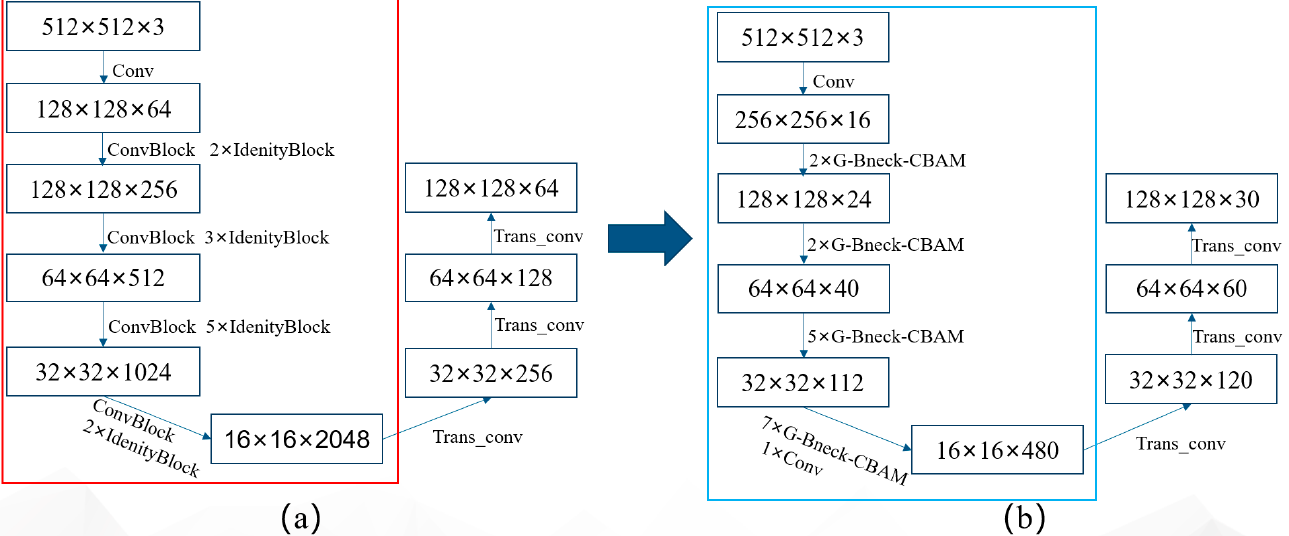
Figure 2. Two detection network frameworks. ( a ) CenterNet with ResNet50 and ( b ) CenterNet with CBAM-Mini-bone (hereinafter referred to as CBAM-Mini).